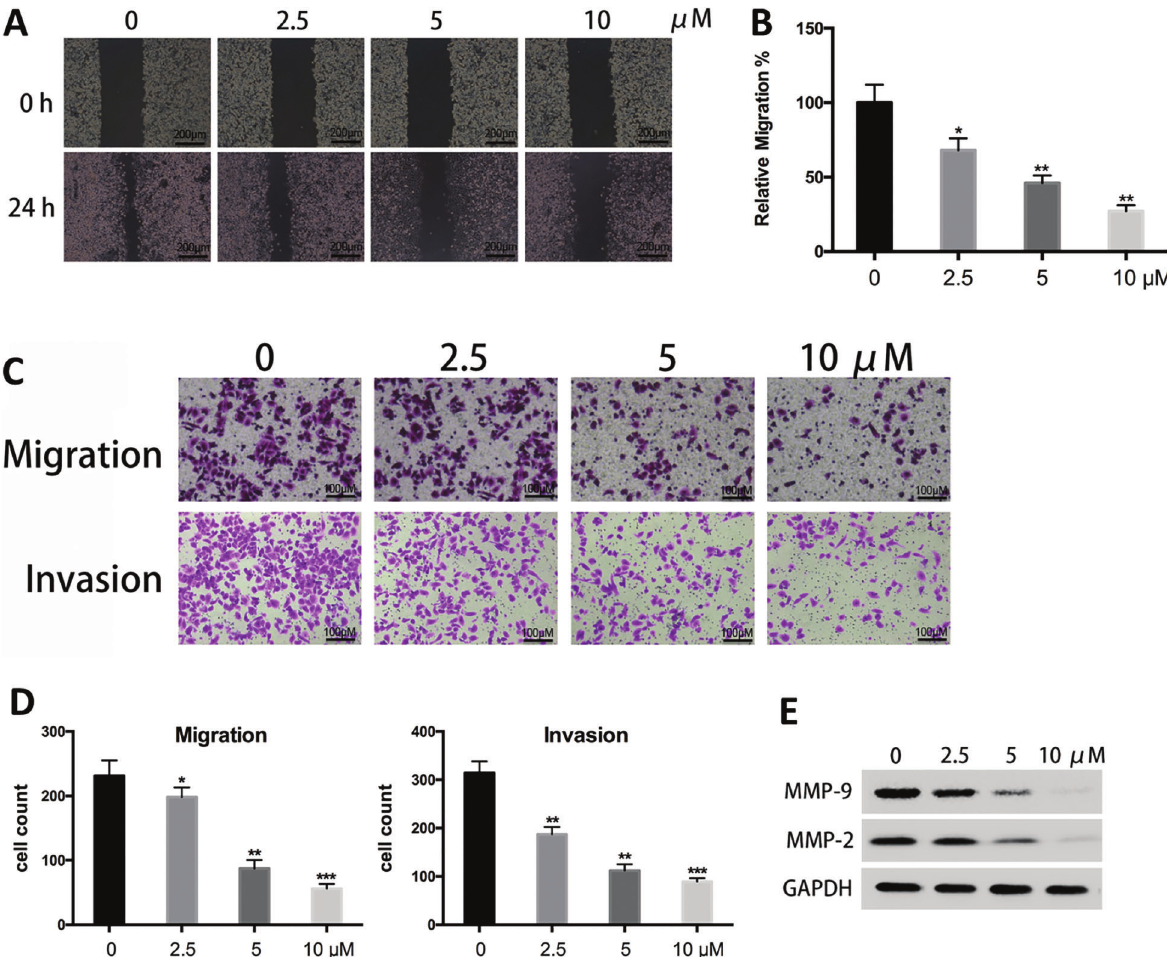
Figure 4. Cantharidin inhibited cell migration and invasion in MDA-MB-231 cells. A , Wound healing assay was performed to observe the effects of cantharidin treatment on MDA-MB-231 cell wound recovery. B , Quanti fi cation of the healed wound area showed that when MDA-MB-231 cells were treated with the LD50 dose (5 m M), wound closure was inhibited by approximately 50% compared to cantharidin-free MDA-MB-231 cells. This inhibition effect was even stronger when cells were treated with cantharidin at a dose of 10 m M. C , Representative images of transwell migration and invasion of cantharidin-treated MDA-MB-231 cells. D , Cell counts of transmigrated cells from the fi ve photographed fi elds in each group. E , Western blot analysis of major MMP-2 and MMP-9 expressions in MDA-MB-231 cells with distinct doses of cantharidin. Data are reported as means ± SD. *P o 0.05; **P o 0.01; ***P o 0.001 compared to control ( t